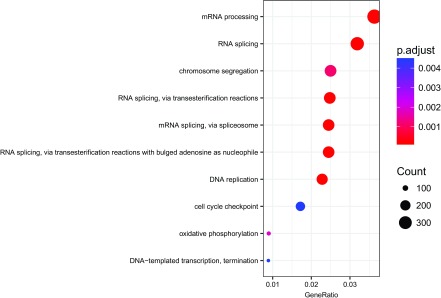
Biological processes enriched in the DE genes.